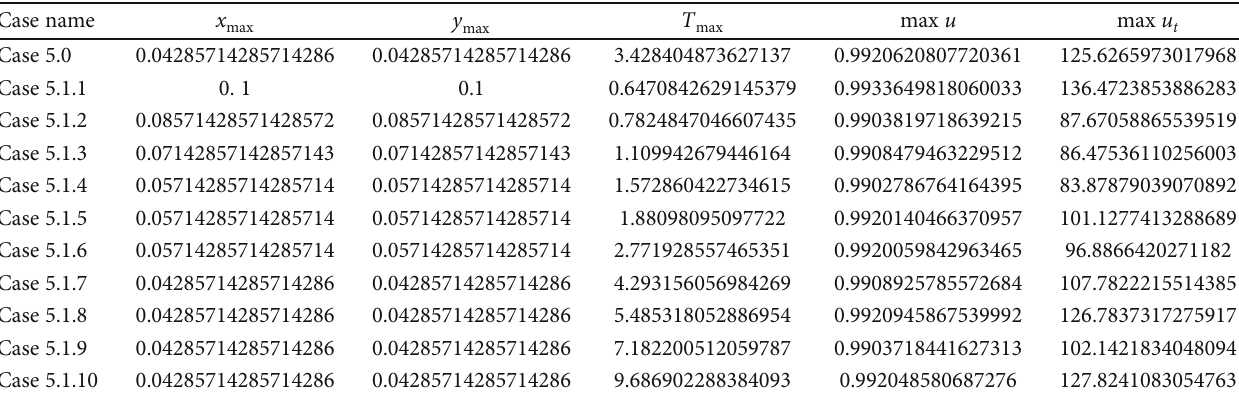
Figure 1: (a) The 3D plots of u immediately before quenching occurs, and (b) the 3D plots of u ffiffiffiffiffi p 10 parameters are q = 0 , a = β = , and θ = 1 without convection term. Table 3: Quenching data of q based on convection term b / ð 1 + α x + β y Þ .